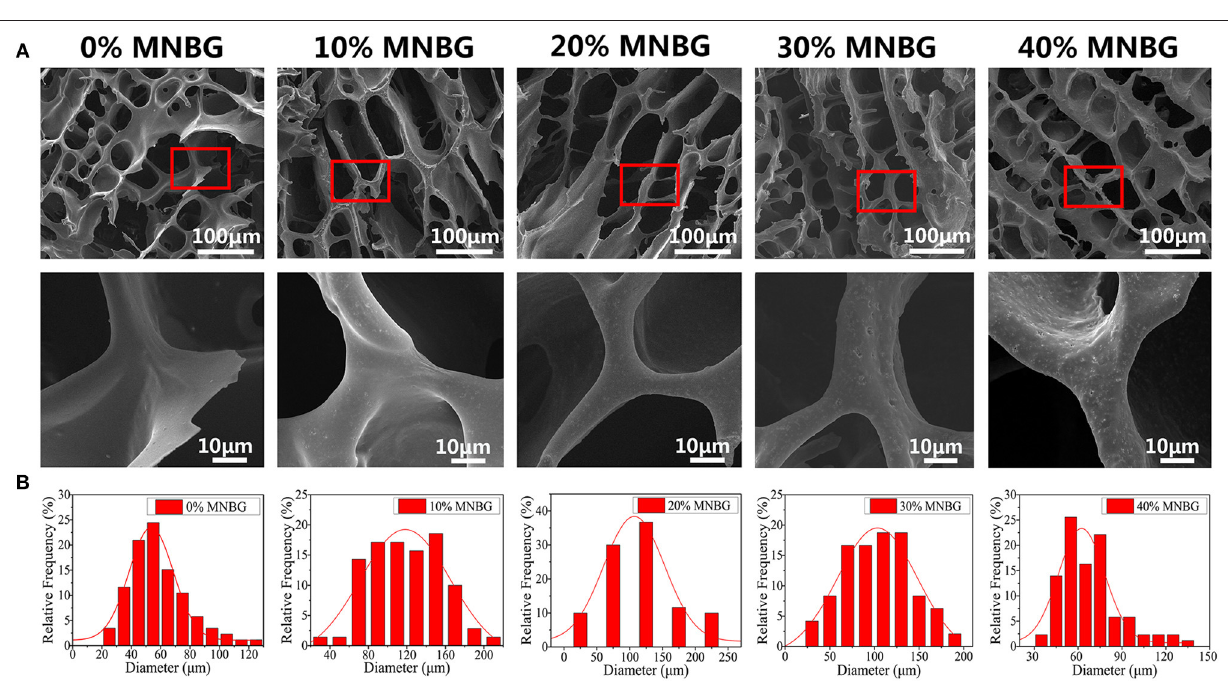
Frontiers in Chemistry | www.frontiersin.org